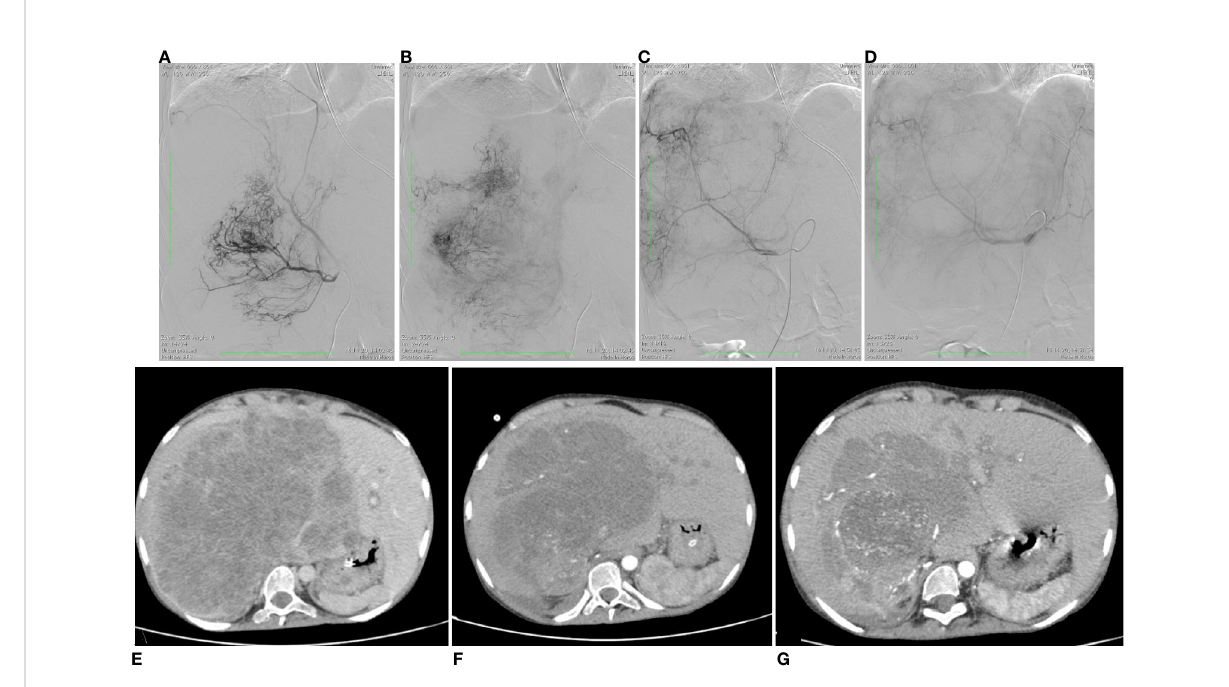
FIGURE 2 Angiographic imaging of the UESL-supplying vessels and MRI images showing favorable dynamics of the liver tumor volume. (A) Proximal portion of the right diaphragmatic artery supplying UESL; (B) distal portion of the right diaphragmatic artery supplying UESL; (C) hepatic artery proper before chemoembolization; (D) hepatic artery proper after chemoembolization, with the catheter left in place for chemoperfusion. (E) before the interventional procedures; (F) after the fi rst session of chemoembolization; (G) after the second session of